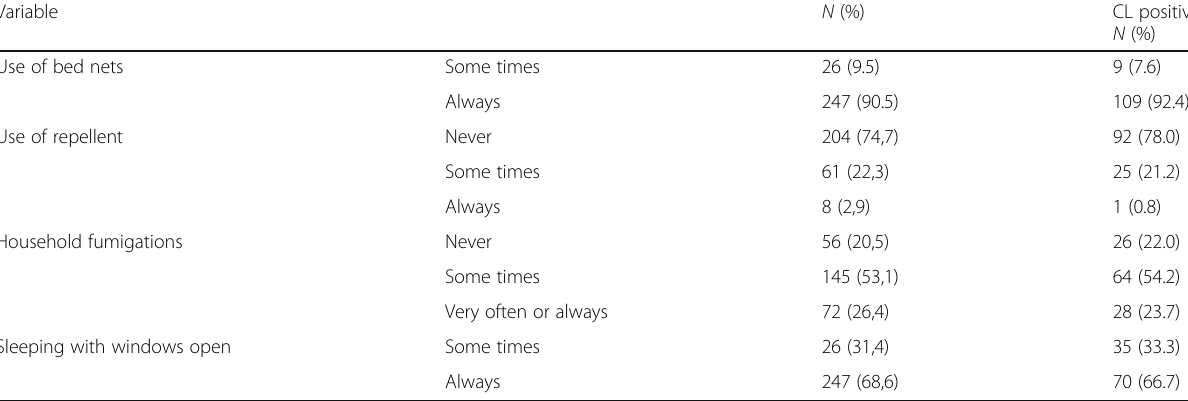
Table 3 Prevention activities of the participants expressed in percentages, Villa Tunari 2015 Variable N (%) Use of bed nets